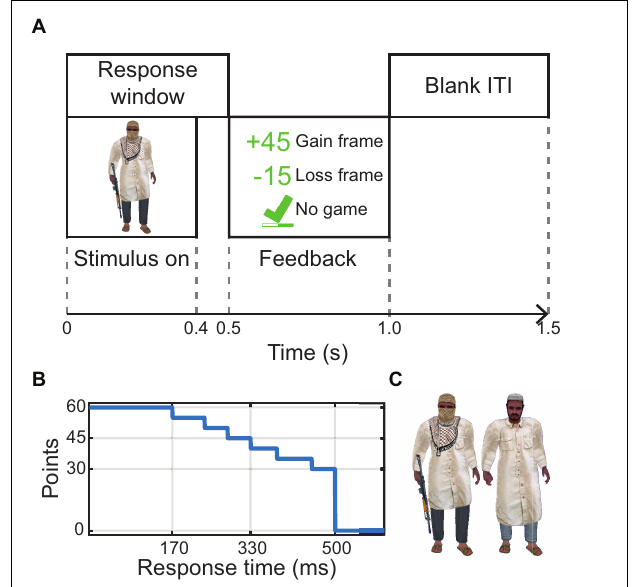
FIGURE 1 | Timeline, point structure, and stimuli. (A) Single trial timeline of a go trial and the three kinds of feedback (gain framed, loss framed, and no points) for a correct response to a go stimulus. Each trial lasted 1.0 s and there was a 0.5 s inter-trial interval (ITI). (B) The curve relating response time relative to stimulus onset to the number of points achieved. (C) The stimuli for threat (go) and non-threat